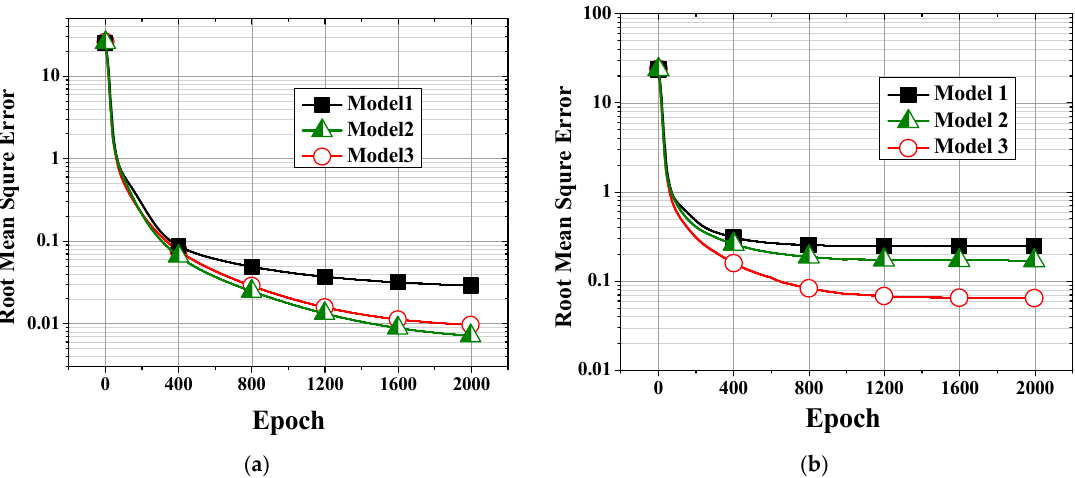
Figure 8. Losses (RMSEs) of the ( a ) training and ( b ) validation datasets.